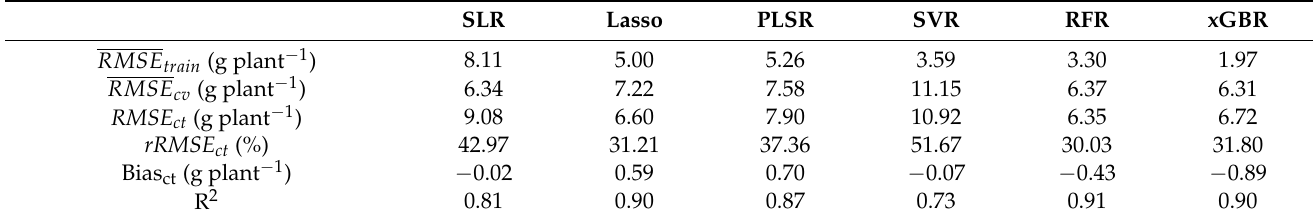
Figure 5. RMSE ct values for all the SLR models for ( a ) DBM (g plant − 1 ) and ( b ) N-uptake (gN plant − 1 ) Figure 5. 𝑅𝑀𝑆𝐸 𝑐𝑡 values for all the SLR models for ( a ) DBM (g plant −1 ) and ( b ) N-uptake (gN ordered from the smallest to largest. plant −1 ) ordered from the smallest to largest. Table 3. Summary of the model performances based on RMSE train across all LOF-CV iterations, the RMSE cv , Bias ct , and R 2 for DBM (g plant − 1 ). The SLR model performance is based on the median RWDRVI